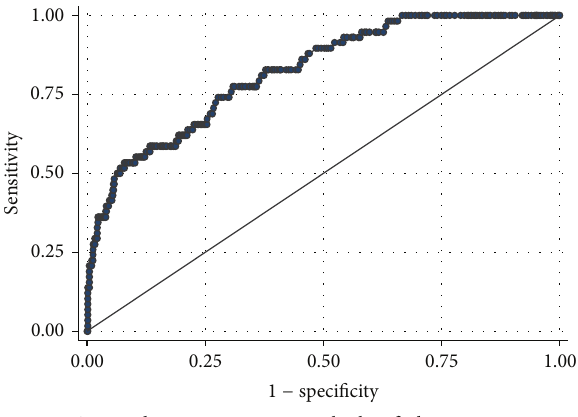
Figure 1: ROC curve to determine the optimal cutoff value of HOMA-IR for MetS diagnosis in healthy adolescents.